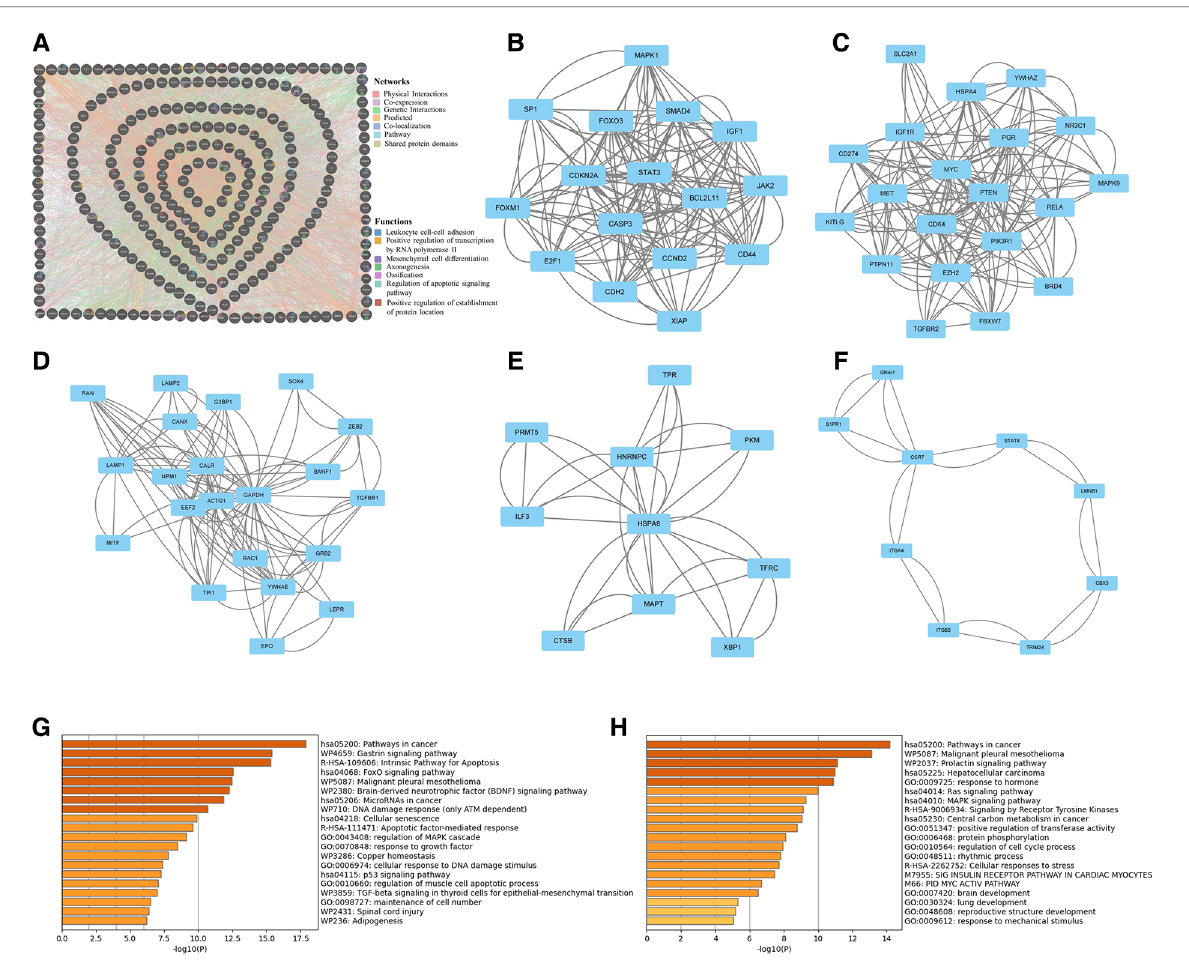
FIGURE 5 Protein – protein interaction network analysis of microRNA-320a-targeted genes which have the effect on OA. ( A ) PPI network was obtained from GeneMANIA database. The nodes represent genes and the edges represent connection between genes. Five key modules were identi fi ed by MCODE, which was used for network gene clustering. ( B ) Cluster 1 with 11.067 score. ( C ) Cluster 2 with 9.579 score. ( D ) Cluster 3 with 6.1 score. ( E ) Cluster 4 with 3.778 score. ( F ) Cluster 5 with 2.5 score. ( G ) Pathway enrichment analysis of cluster 1. The MAPK signaling pathway was signi fi cantly enriched. ( H ) Pathway enrichment analysis of cluster 2. The MAPK signaling pathway was signi fi cantly